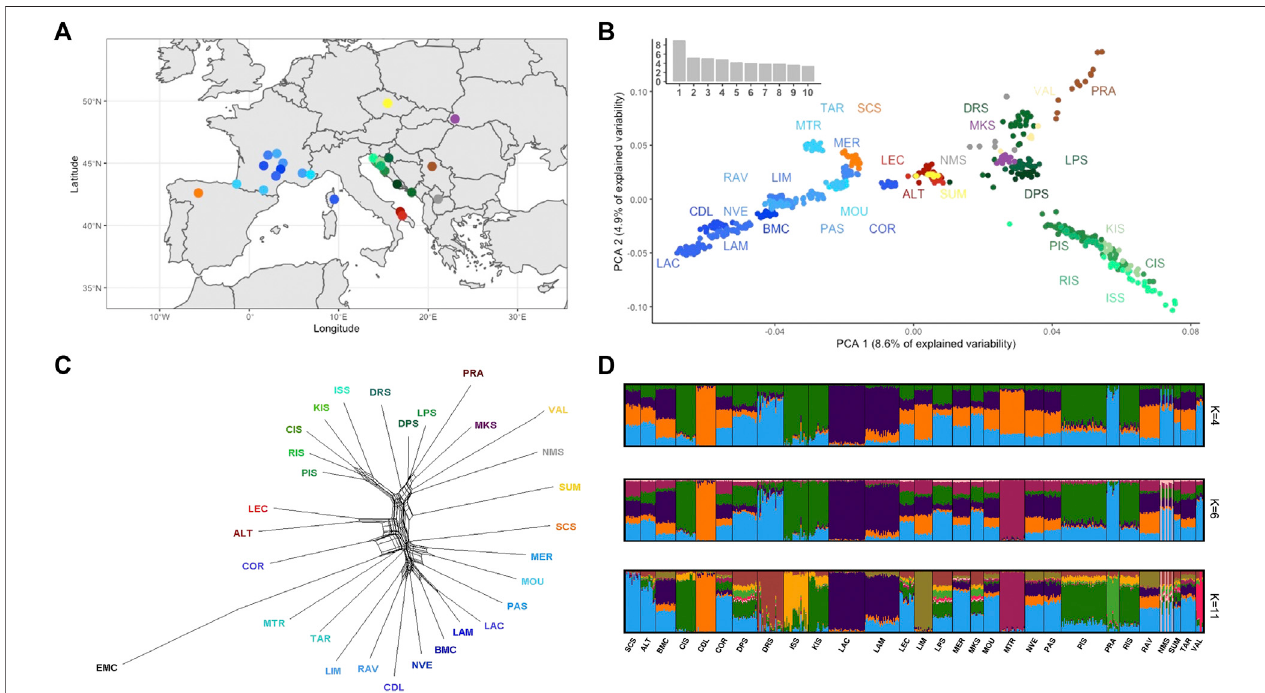
FIGURE 2 | (A) Map of the origin of the breeds used in the Mediterranean dataset; (B) PCA plot for Mediterranean sheep breeds with principal component 1 and principalcomponent2.; (C) NeighbournetworkbasedontheNeigeneticdistancesconstructedforMediterraneandataset; (D) Graphicalpresentationsofthepopulation structureanalysesforasampleof574Mediterraneansheep. Eachsheepisrepresented byasingleverticallinebrokenintoKcoloursegments,withlengthsproportional to the estimated membership of the inferred cluster. Each country is presented with different colour: Croatia — green; France — blue; Spain — orange; Italy — red; North-Macedonia — grey;Ukraine — purple;CzechRepublic — yellow;Serbia — brown.Withinacountry,eachbreedisrepresentedwithadifferentmaincolourandthree- letter coding:DRS, DubrovnikSheep;LPS,LikaPramenka;DPS,Dalmatian Pramenka;PIS,PagIslandSheep;RIS,RabIslandSheep; CIS,CresIslandSheep;KIS,Krk